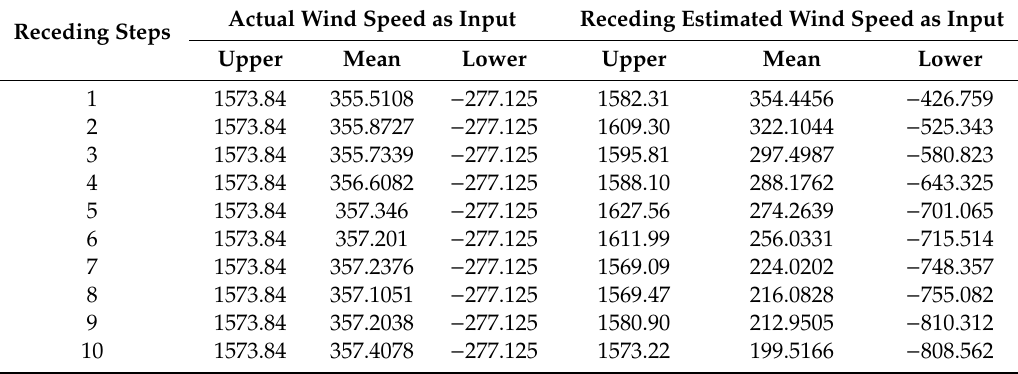
Table 8. Error statistic of ten-step wind power prediction via KDE.